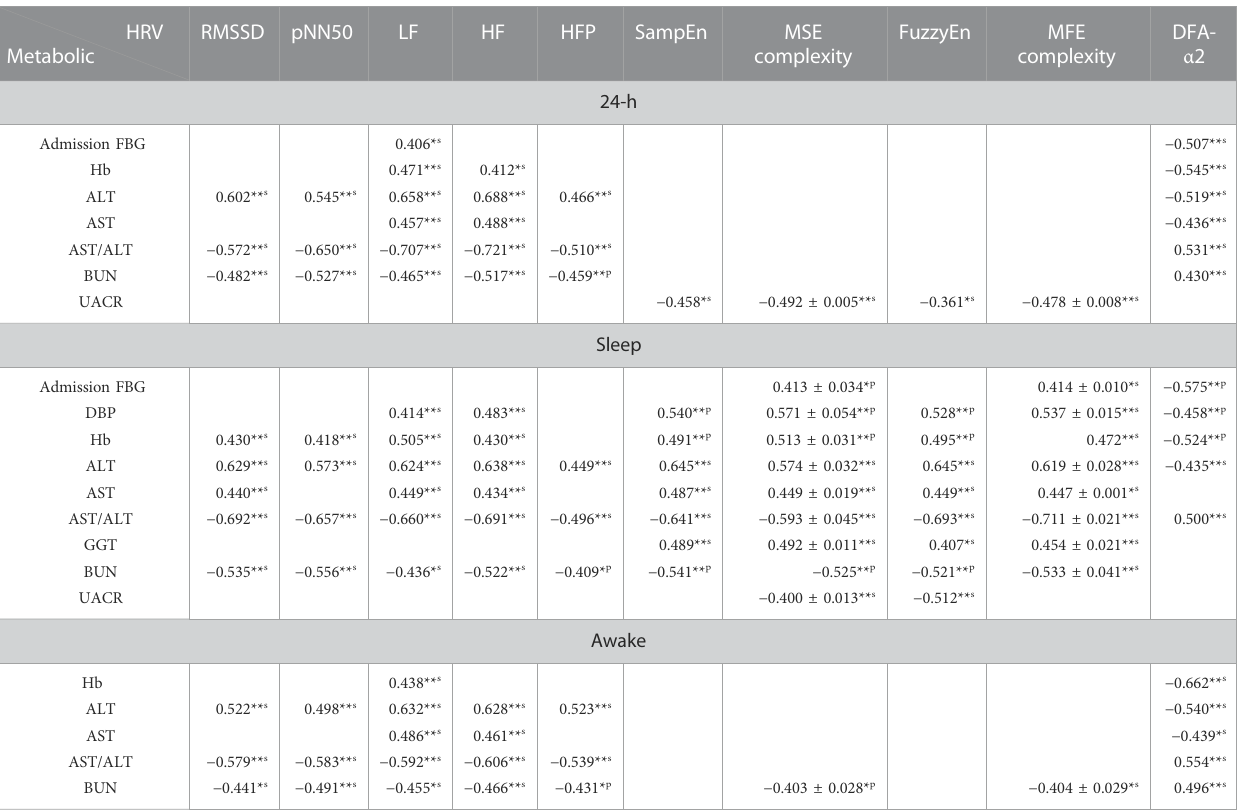
TABLE 5 Correlation coef fi cients between HRV metrics during different recording period and clinical